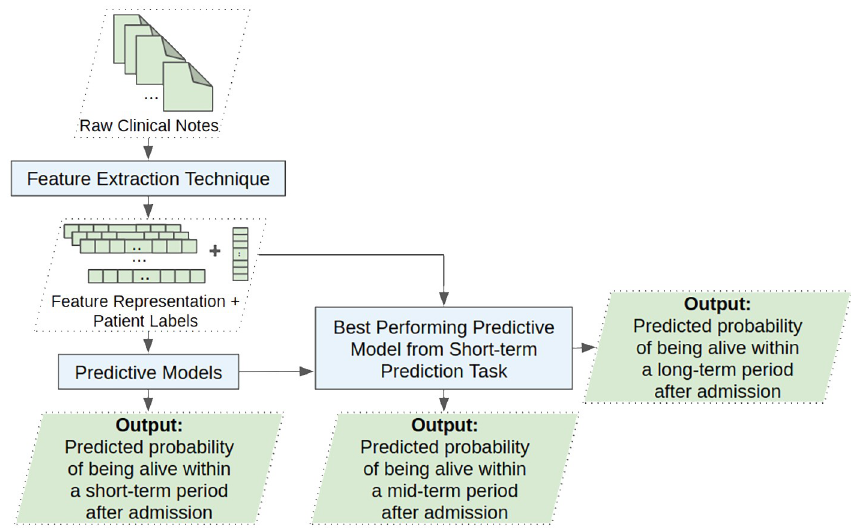
Fig 1. Proposed framework for short-term, mid-term and long-term mortality prediction tasks.